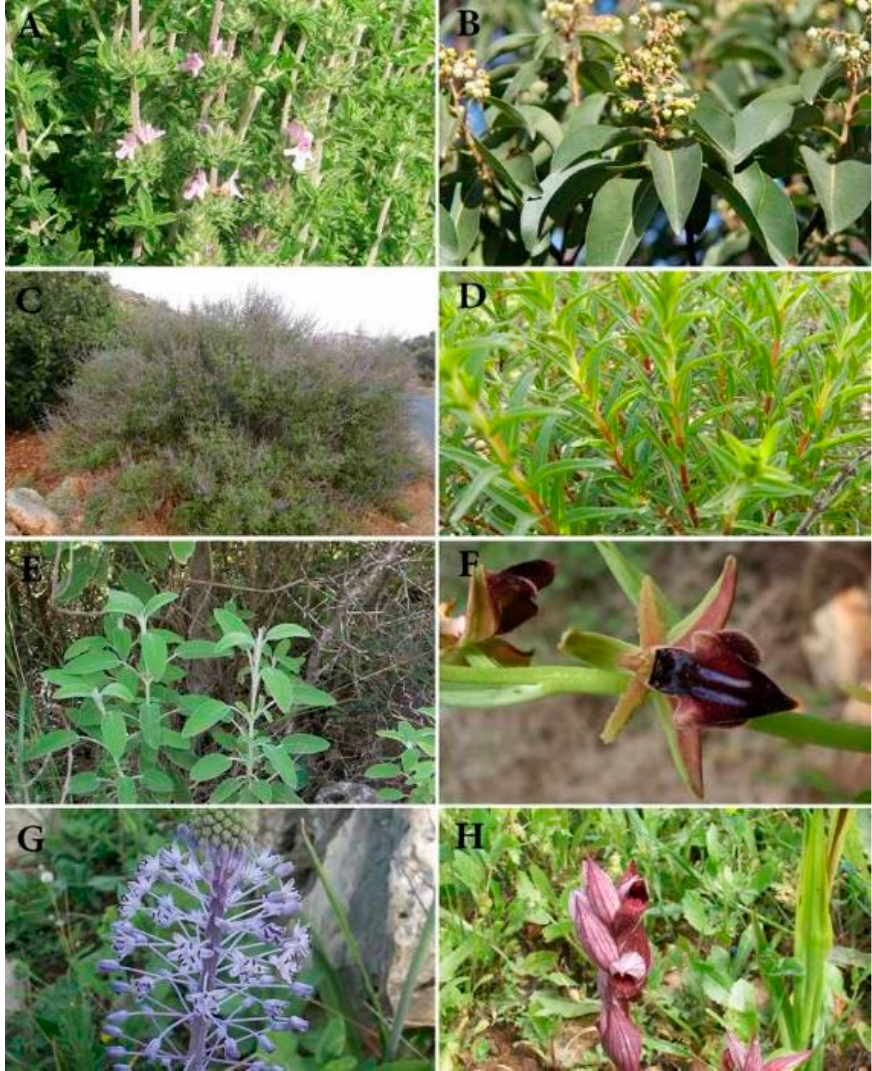
Figure 5. Selected plants in WZ. ( A ). Satuja thymbra . ( B ). Arbutus andrachne . ( C ). Vitex agnuscastus . ( D ). Thymbra spicata . ( E ). Salvia fruticose . ( F ). Ophrys cf. adonidis . ( G ). Scilla hyacinthoides . ( H ). Serapias vomeracea .